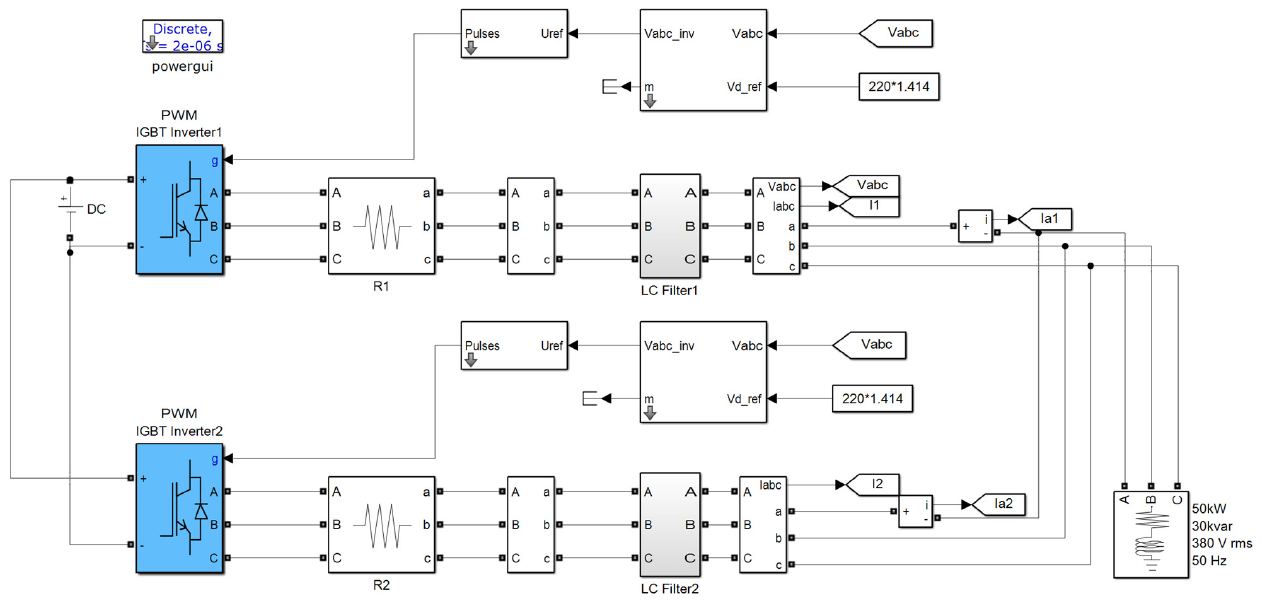
Figure 9. Main circuit of double inverter parallel current sharing simulation model.